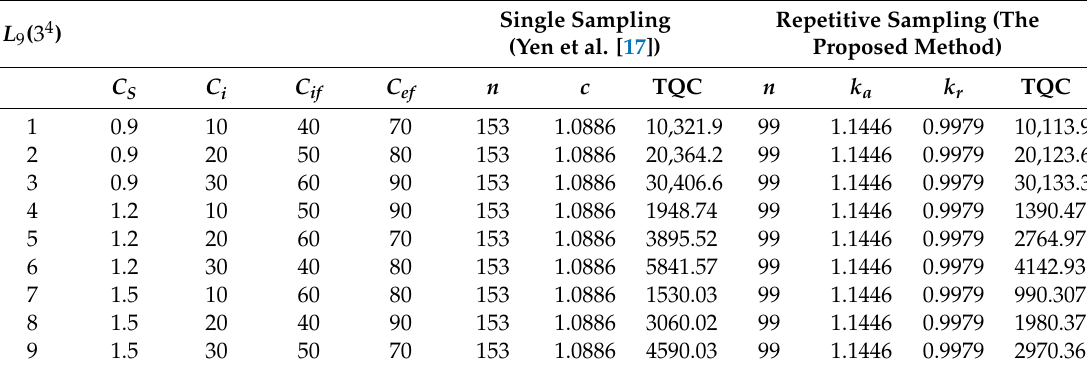
Table 4. Sensitivity analysis for simultaneous changes in parameters.